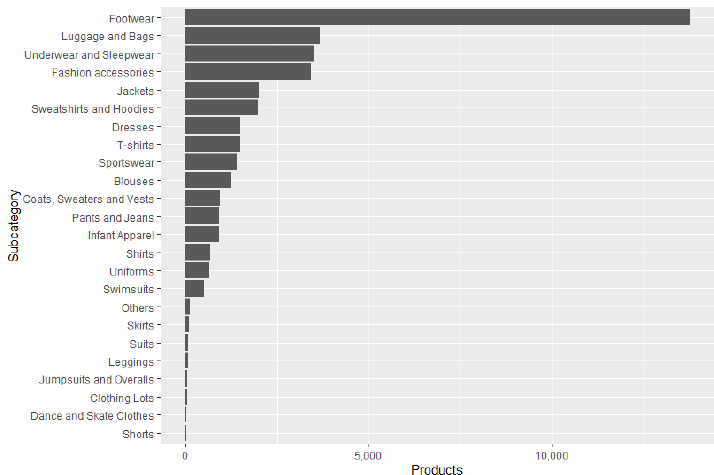
Figure A1. Number of products within each category.